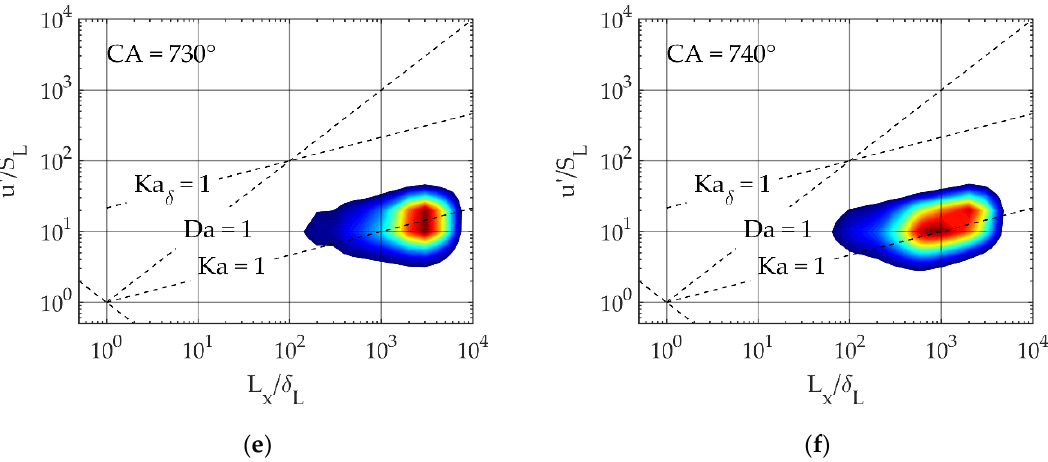
Figure 15. Volume-based probability of the combustion regimes present in the evaluated area in front of the flame for a crank angle of 706° ( a ), 710° ( b ), 715° ( c ), 720° ( d ), 730° ( e ) and 740° ( f ).